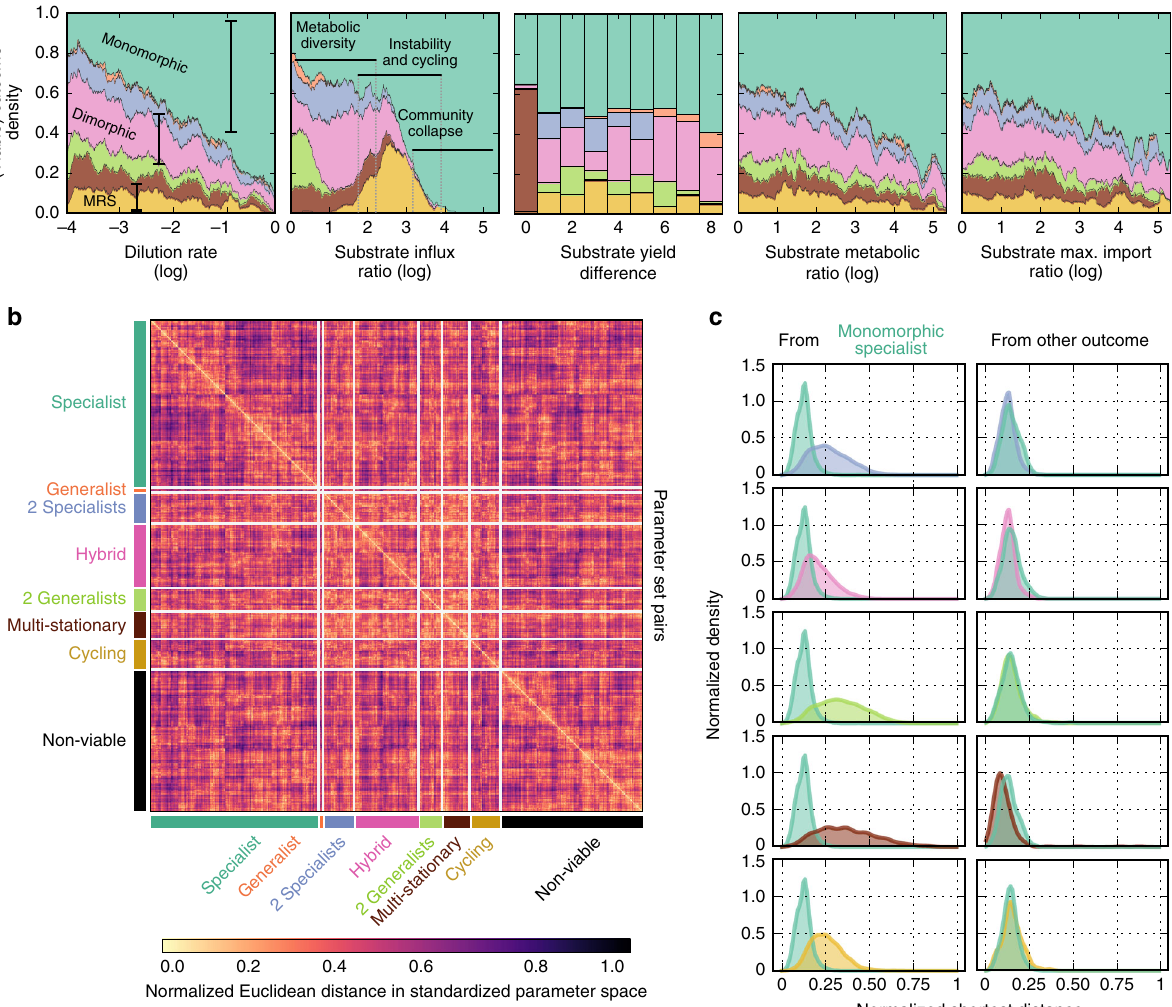
Fig. 4 A complex association exists between the environment and the evolutionary outcomes. Overlapping clusters of evolutionary outcomes in environmental parameter space make prediction dif fi cult and explain sensitivity of microbial communities to environmental change. a Some evolutionary outcomes are more likely to be associated with certain parameter values, but without a simple dependence. Using a nearest-neighbors algorithm, we empirically estimated the density of each outcome from sampling parameters. For all combinations of parameters except the dilution rate, we show densities at absolute values because of the symmetry about zero. Colors for the outcomes follow Fig. 3a. b Evolutionary outcomes form clusters in the space of parameters but these clusters are not distinct. We used Euclidean distance in a standardized space of parameters to perform within-outcome hierarchical clustering and then aligned clusters with samples from other outcomes to assess their overlap. We only plot a representative sample (1%) of the data set, which preserves the observed frequencies of each outcome. Distinct clusters would appear as bright regions in the diagonal combined with dark regions in the off-diagonal rows and columns indicating that samples with the same outcome are closer to each other than they are to samples with different outcomes. Instead, we found that clusters for one outcome are almost always proximal to samples from other outcomes (bright off-diagonal regions). c Environmental perturbations often cause community collapse and only rarely create diverse communities. We calculated the distance in the standardized space of parameters from each process to the closest process in all other outcome classes and so formed distributions of shortest distances. The left column shows per panel the shortest distances from the monomorphic specialists to themselves and to one other outcome. The monomorphic specialists are generally closer to other monomorphic specialists than they are to other outcomes. The right column shows per panel the shortest distances from one other outcome to itself and to the monomorphic